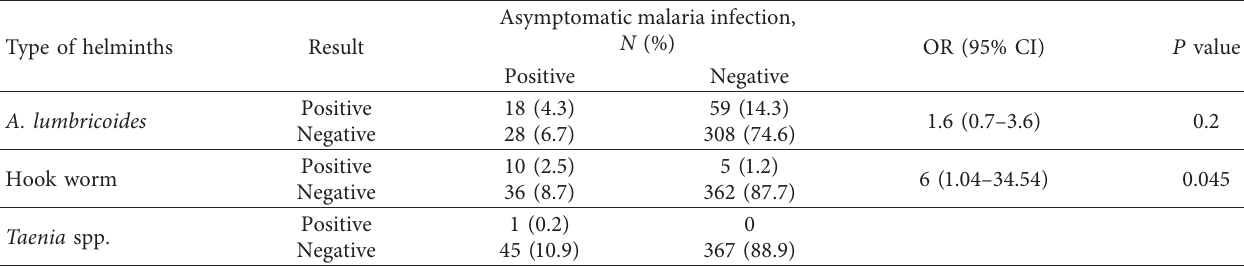
Table 5: Prevalence of asymptomatic malaria and helminths coinfection among the age and sex group of primary school children in Gedeo zone, Southern Ethiopia. Variables